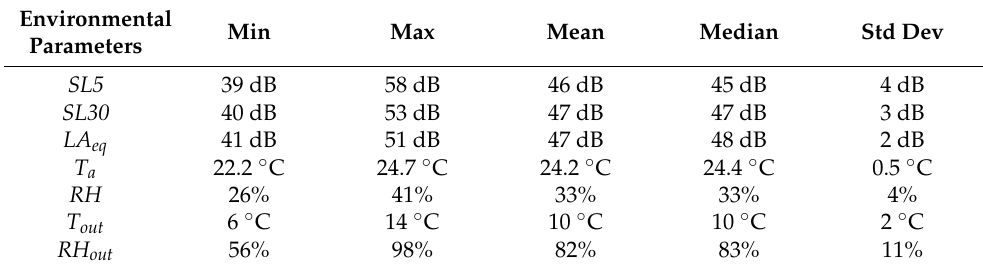
Table 4. Descriptive statistics of the main environmental parameters monitored at Stage 3.